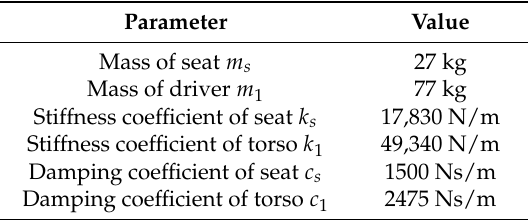
Table 2. Parameters of MR damper.